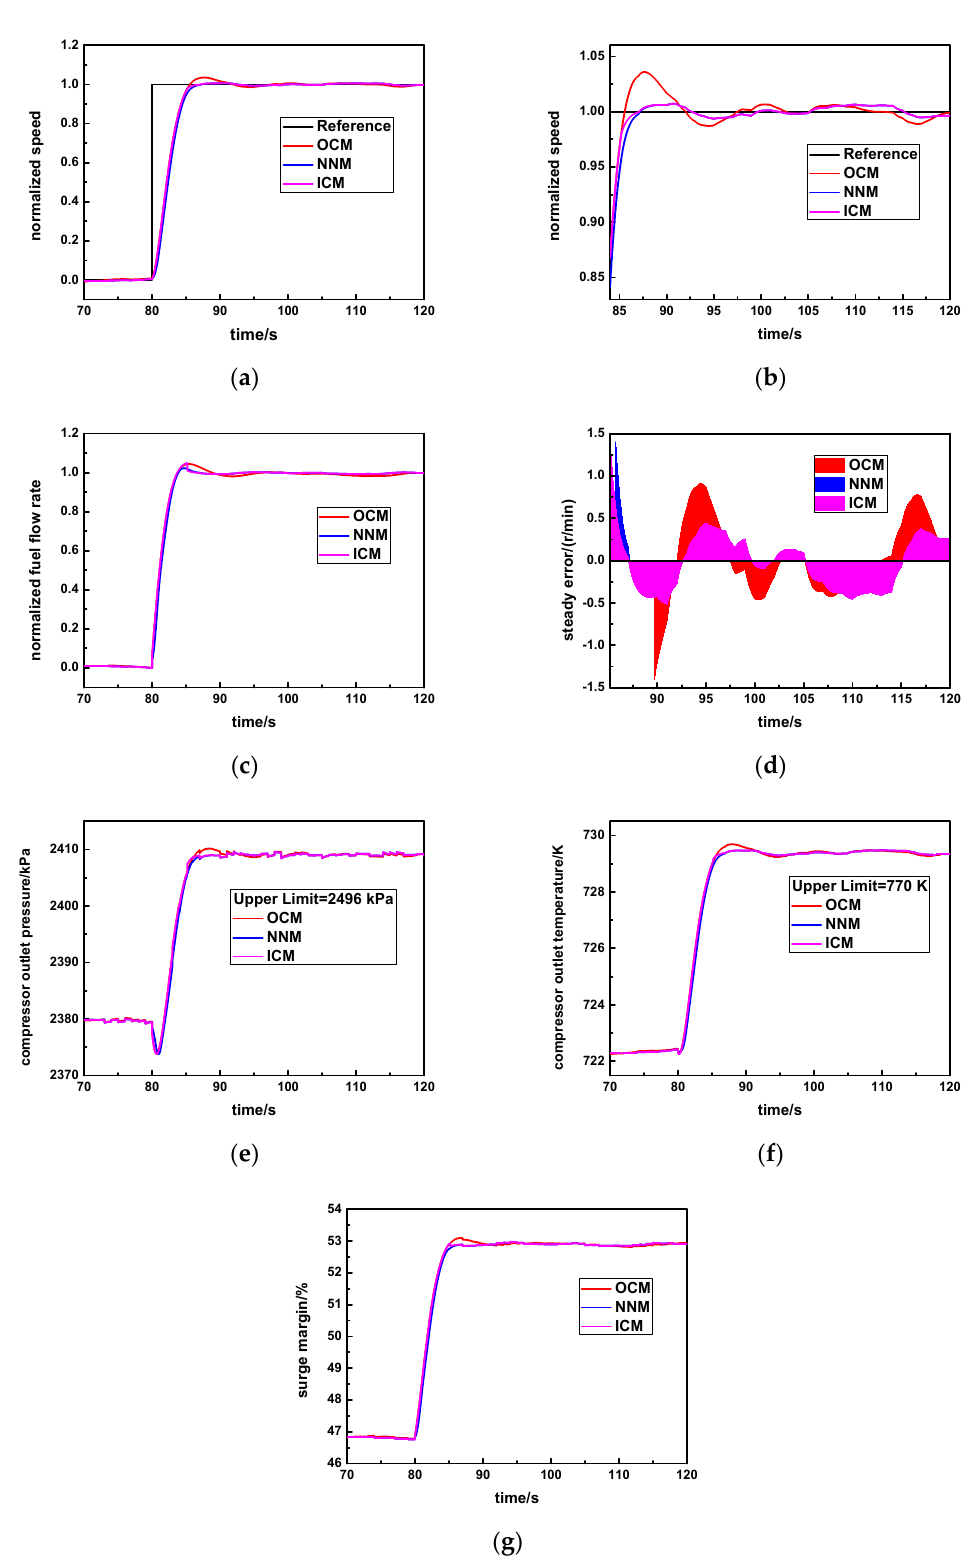
Figure 10. Related parameters distribution of second step test. ( a ) Speed response curve, ( b ) Locally enlarged speed curve, ( c ) Fuel flow rate, ( d ) Steady error, ( e ) Compressor outlet pressure, ( f ) Com- pressor outlet temperature, ( g ) Surge margin of compressor.